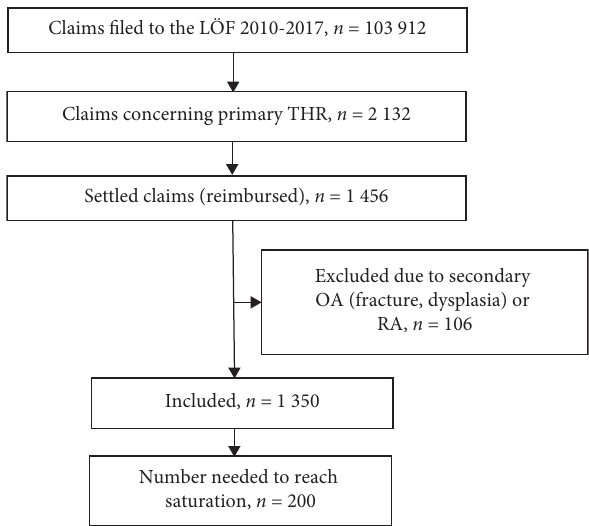
Figure 1: Selection of the study